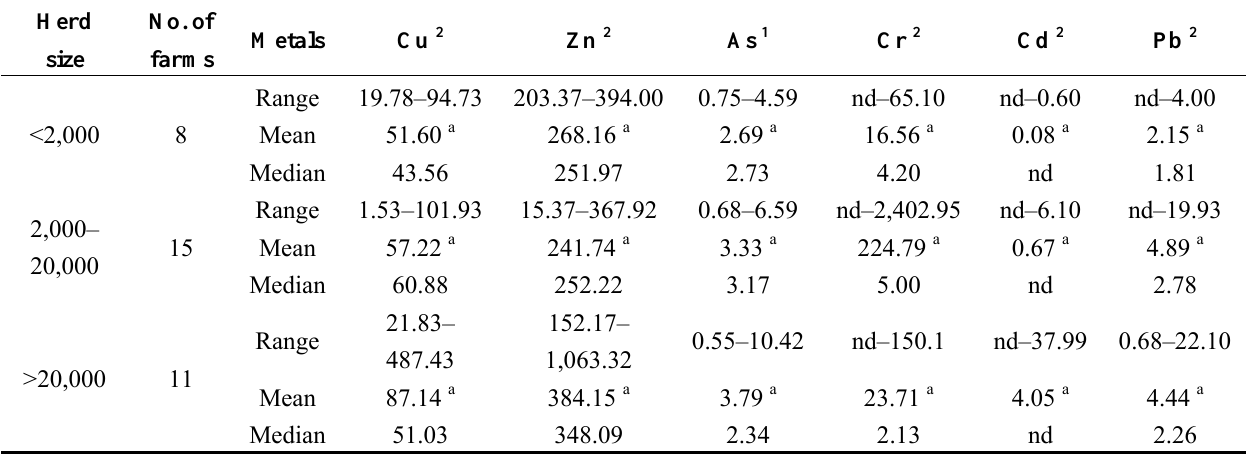
Table 6. Heavy metals in chicken manure from farms of different herd size (mg/kg dm).